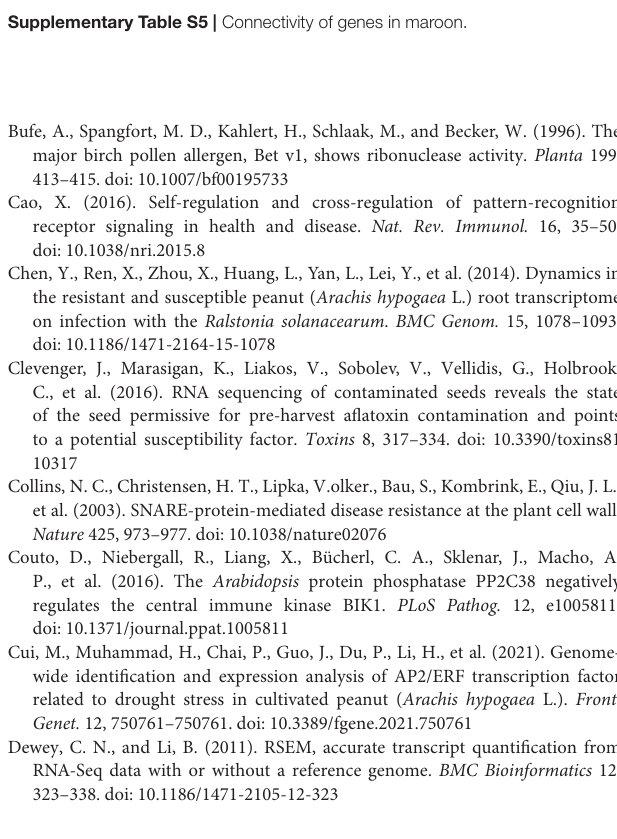
Supplementary Figure S1 | Distribution of sequencing saturation of S -T5 and S -T7. Supplementary Figure S2 | Pairwise Pearson’s correlation coefficients of the sequencing data of 36 samples. Supplementary Figure S3 | Principal component analysis of the sequencing data of 36 samples. Supplementary Figure S4 | Top 30 GO term enriched functional categories of DEGs upregulated uniquely in R at T1 (A) , T2 (B) , T3 (C) , T5 (D) , and T7 (E) . Supplementary Figure S5 | Top 30 of KEGG enrichment of DEGs upregulated uniquely in R at T1 (A) , T2 (B) , T3 (C) , T5 (D) , and T7 (E) . Supplementary Figure S6 | Top 30 GO term enriched functional categories of DEGs upregulated uniquely in S at T1 (A) , T2 (B) , T3 (C) , T5 (D) , and T7 (E) . Supplementary Figure S7 | Top 30 of KEGG enrichment of DEGs up-regulated uniquely in S at T1 (A) , T2 (B) , T3 (C) , T5 (D) , and T7 (E) . Supplementary Figure S8 | Heat map of module-module relationship. Supplementary Figure S9 | Top 30 GO term enriched functional categories and top 30 KEGG enrichments of DEGs in salmon4 and maroon. Supplementary Table S1 | Primers used for RT-qPCR analysis. Supplementary Table S2 | Detail information of sequencing reads from different sample groups. Supplementary Table S3 | Gene number of each module. Supplementary Table S4 | Connectivity of genes in salmon4. Supplementary Table S5 | Connectivity of genes in